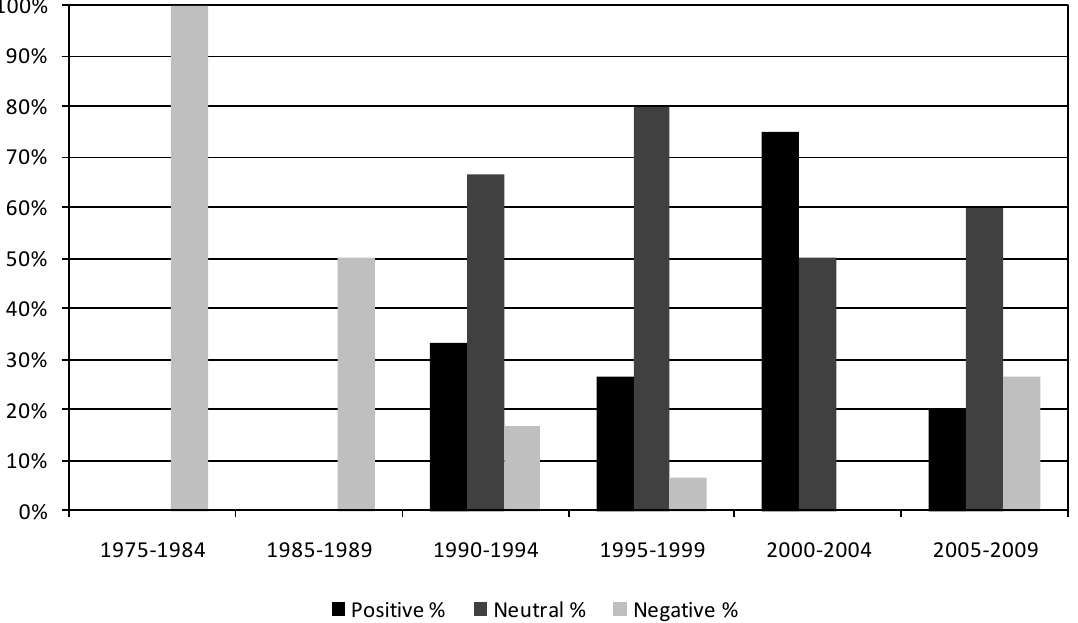
Figure 5: Financial performance over time